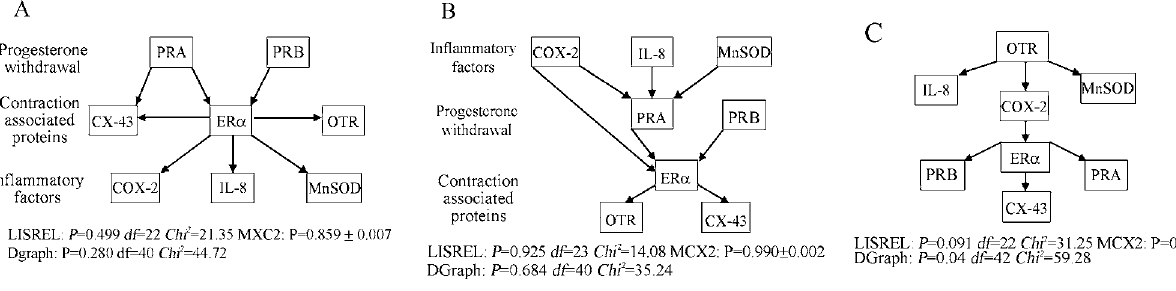
Figure 1. Directed Graphs of Messenger RNA Abundances in Human Myometrium Three models were generated and are represented in the following graphics. (A) Does progesterone withdrawal initiate labour? (B) Does inflammation initiate labour? (C) Does oxytocin receptor mediate onset of labour? DOI: